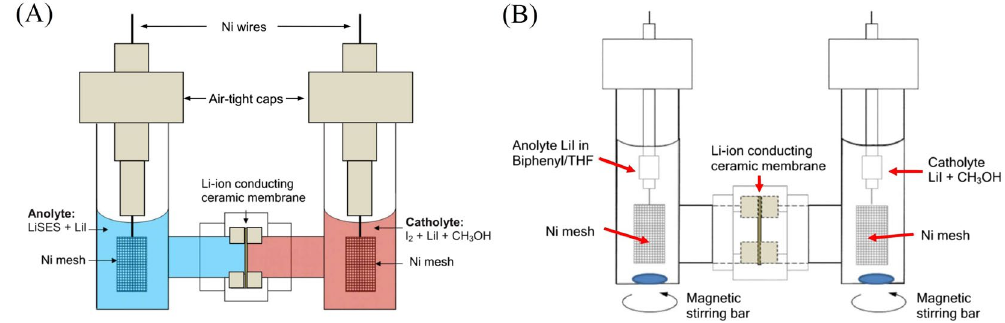
Figure 1. ( A ) Schematic diagram of cell in 100% state-of-charge (S.O.C.) 11 . ( B ) Schematic diagram of cell in 0% state-of-charge (S.O.C). The entire cell sits on two magnetic stirring plates which keep the stirrer bars in the cell